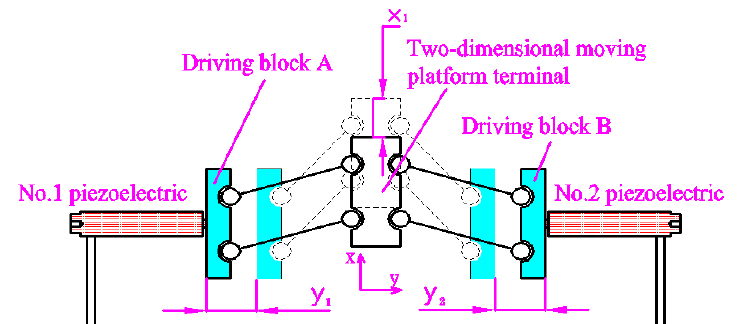
Figure 4. Principle of x -direction motion of 2D motion platform.